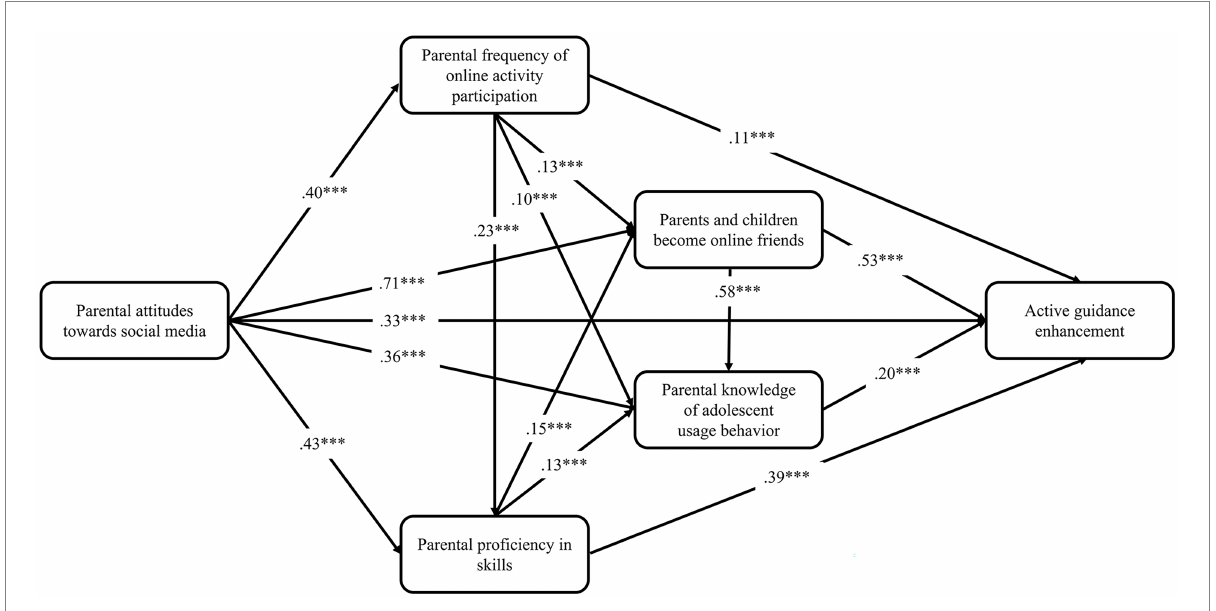
FIGURE 3 Predictive path coefficients of active guidance enhancement. * p < 0.05, ** p < 0.01, *** p <